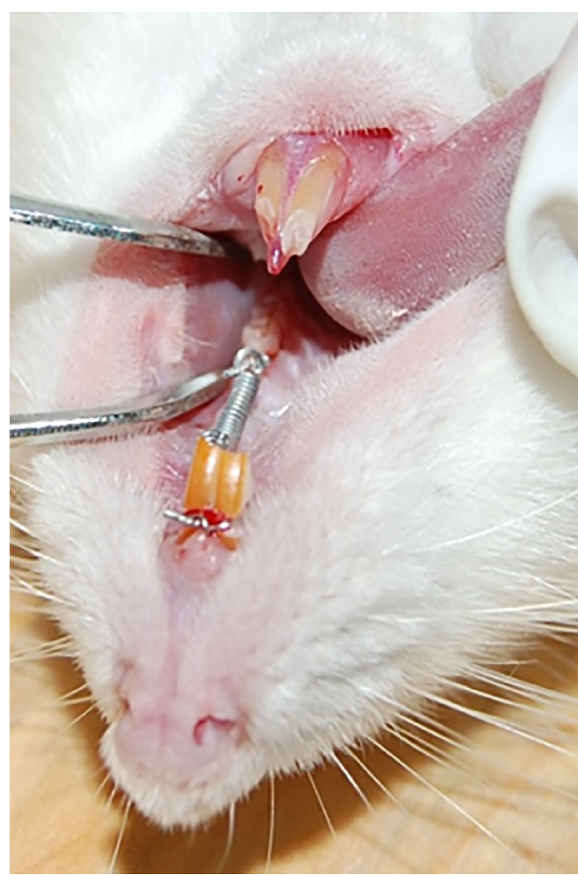
Figure 1- The orthodontics appliance and rat tooth movement model. The Ni-Ti closed-coil spring was wrapped with orthodontic ligation wire, a 50 g force was applied to the left first molar of the rats, and the other end was attached to the ipsilateral